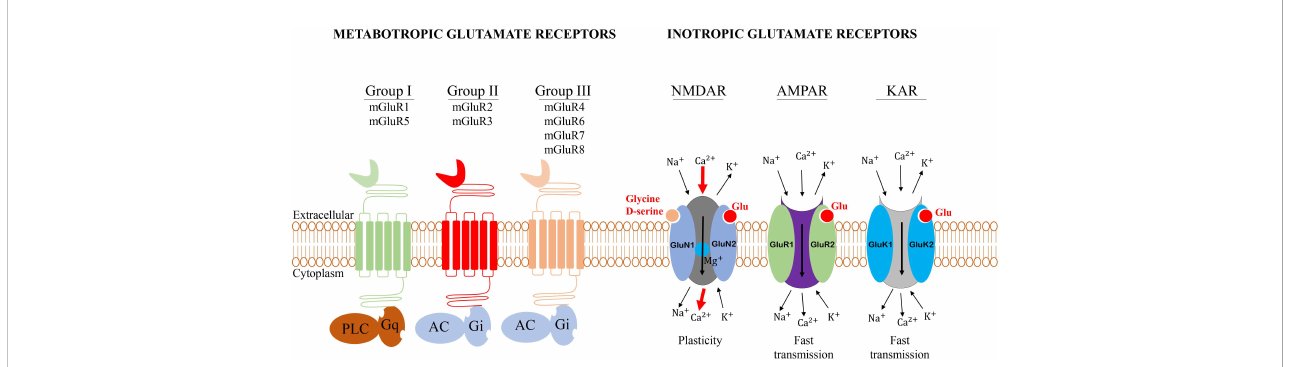
FIGURE 2 General structure of glutamate receptors. Metabotropic glutamate receptors belong to the family C G-protein-coupled receptors (GPCR). Group I mGluRs is coupled to phospholipase C, while groups II and III are negatively coupled to adenylate cyclase (AC). The iGluRs are ligand-gated cation channels that are divided into three groups: N -methyl-D-aspartate (NMDA), a -amino-3-hydroxy-5-methyl-4-isoxazole propionic acid (AMPA), and 2- carboxy-3-carboxymethyl-4-isopropenyl pyrrolidine (kainate, KA)